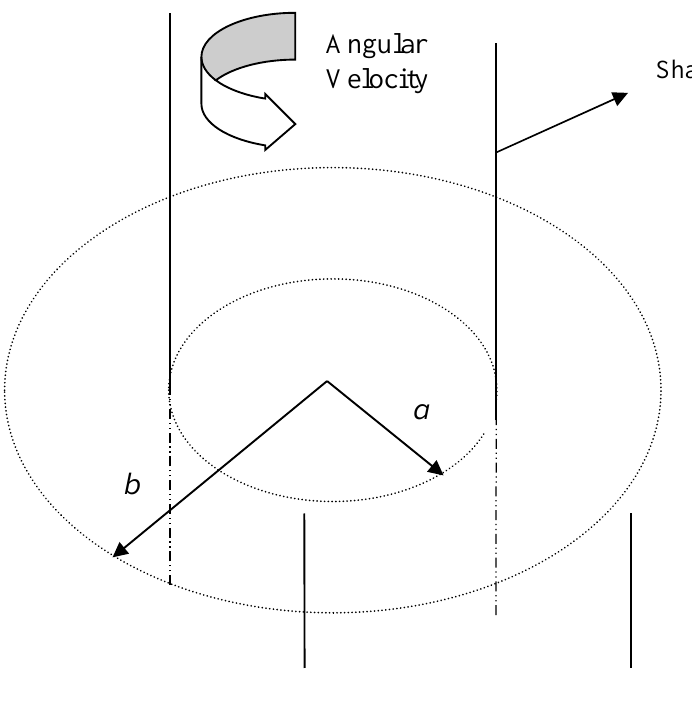
Figure1. Geometry of rotating spherical